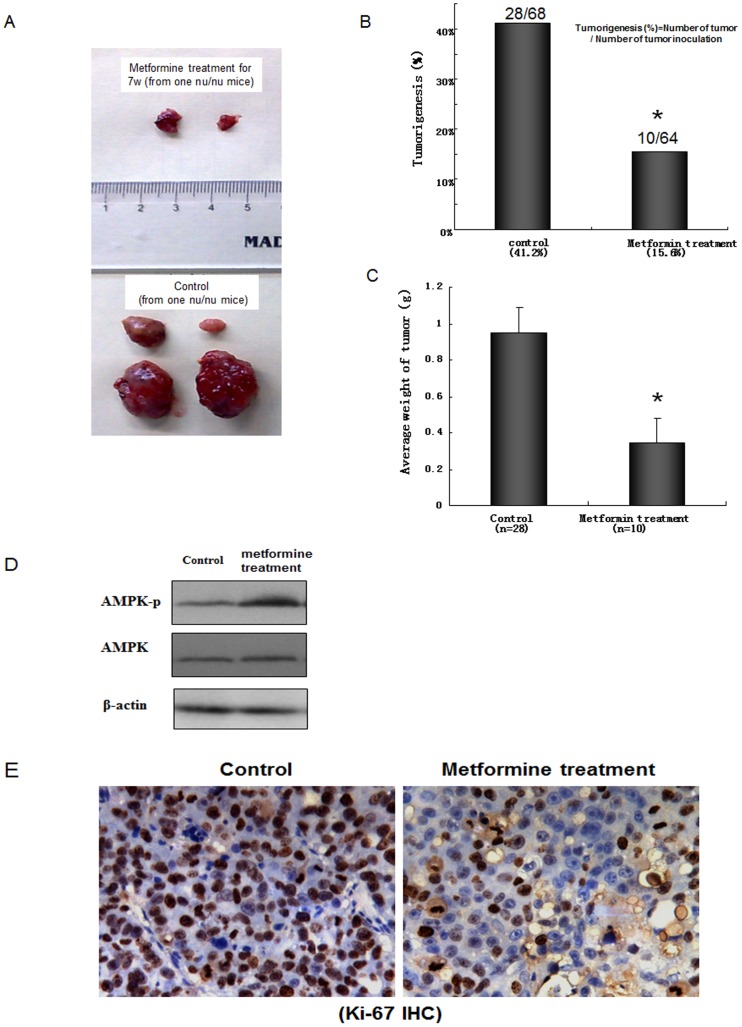
Metformin abrogated the growth of HCC xenografts in nude mice.PLC/PRF/5 cancer cells (2×106) were inoculated s.c. in 5-week old male nu/nu mice at both flanks for 4 points. After 1 week, metformin was dissolved in PBS and given i.p. (30 Ag/g body weight). The control group received PBS only. Control and metformin-treated groups were treated for 7 weeks. (A): Representative picture for tumorigenesis number and size in control and metformin treatment nu/nu mice. (B): The tumorigenesis percentage. (C): Average tumor weight. (D): Western blot analysis of phosphor-AMPK (AMPK-p) and AMPK in control and metformin treated groups. (E): The expression of Ki-67 in control and metformin-treated groups by immunohistochemistry. Data are mean±SD. *p<0.05.